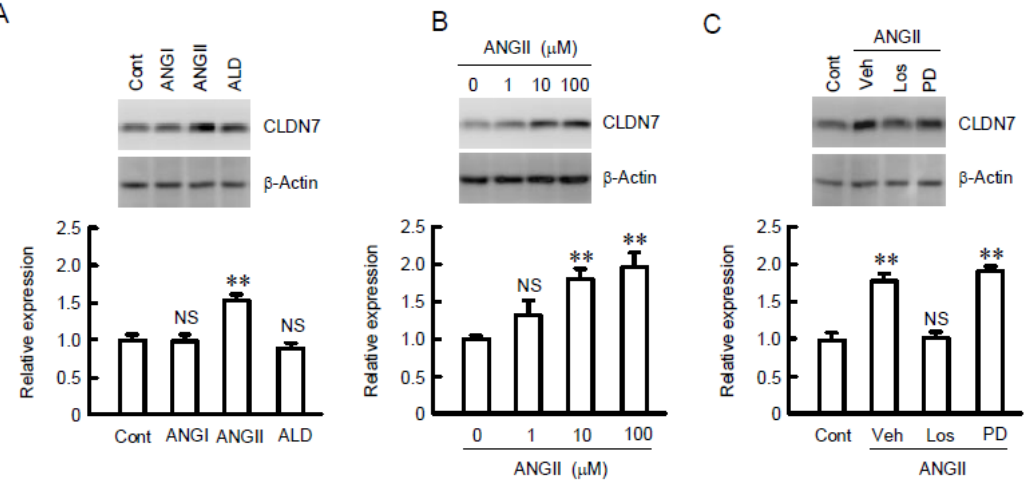
Figure 2. Increase in CLDN7 expression by ANGII in MCE301 cells. ( A ) Cells were treated with 10 µM ANGI, 10 µM ANGII, or 50 nM aldosterone (ALD) for 24 h. Control cells (Cont) were not treated with these chemicals. Cytoplasmic extracts including membrane and cytoplasmic proteins were immunoblotted with anti-CLDN7 or β-actin antibody. The content of CLDN7 was represented relative to the values in control. ( B ) Cells were treated with ANGII for 24 h in the concentration indicated. Cytoplasmic extracts were immunoblotted with anti-CLDN7 or β-actin antibody. The content of CLDN7 was represented relative to the values in 0 µM. ( C ) Cells were treated with 10 µM ANGII for 24 h in the presence and absence of 10 µM losartan (Los) or 10 µM PD123319 (PD). Cytoplasmic extracts were immunoblotted with anti-CLDN7 or β-actin antibody. The content of CLDN7 was represented relative to the values in control. n = 4. ** p < 0.01 significantly different from Cont or 0 µM. NS p > 0.05 not significantly different.